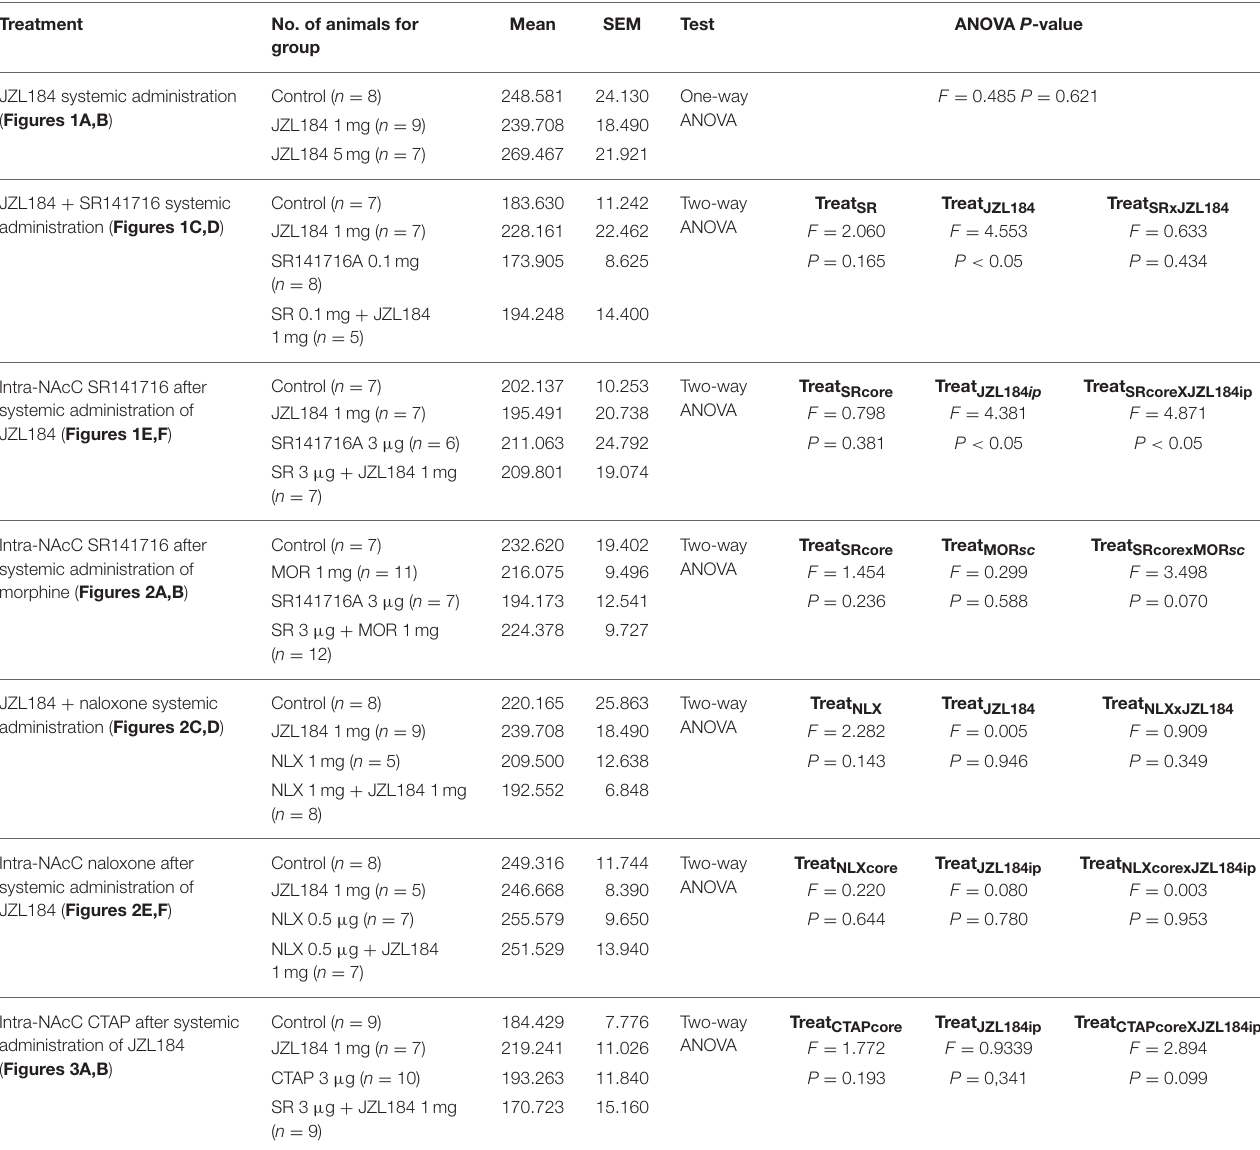
Table 3 ]. Post-hoc analysis revealed that JZL184 (1 mg/Kg) increased social play when co-administered with vehicle but not when the animals were pretreated with naloxone. In